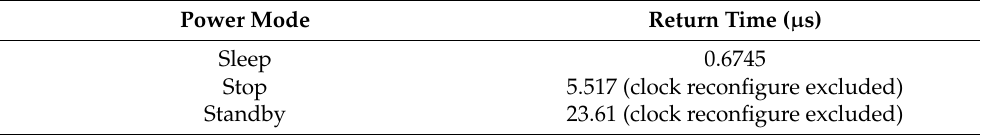
Table 3. Time required to return from different power